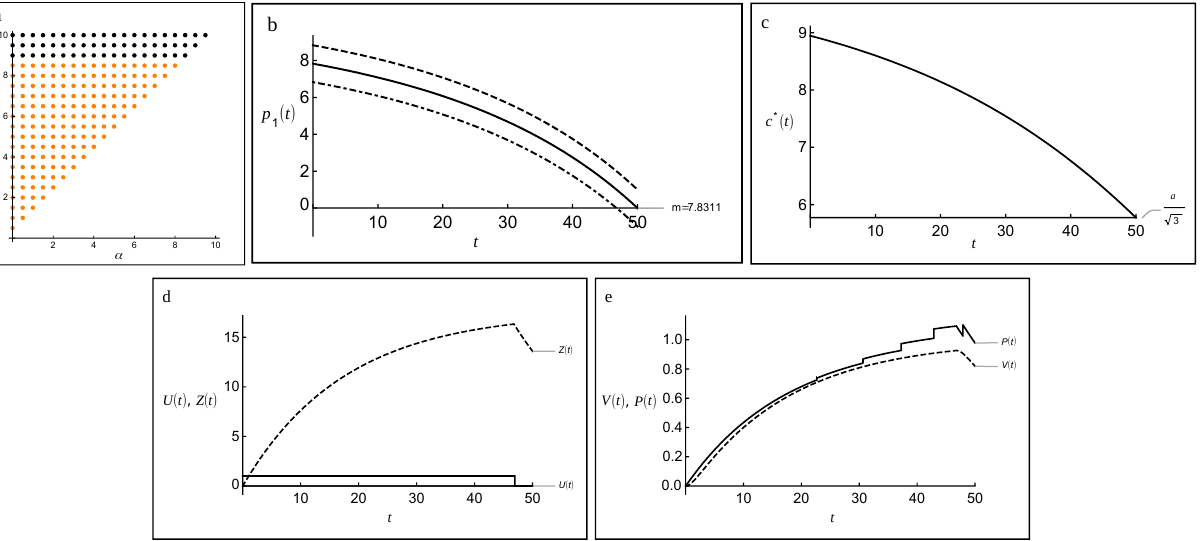
Figure 9. ( a ) Initial state; ( b ) dependence p 1 ( t ) , graphs of the functions p 1 ( t ) ± 1.0 are given for clarity; ( c ) the price function depending on the time; ( d ) functions U , Z depending on the time; ( e ) functions V , P depending on the time. Values of the parameters of the dynamic system: a = 10, U 0 = 1, T = 50, k 1 = 1.0.